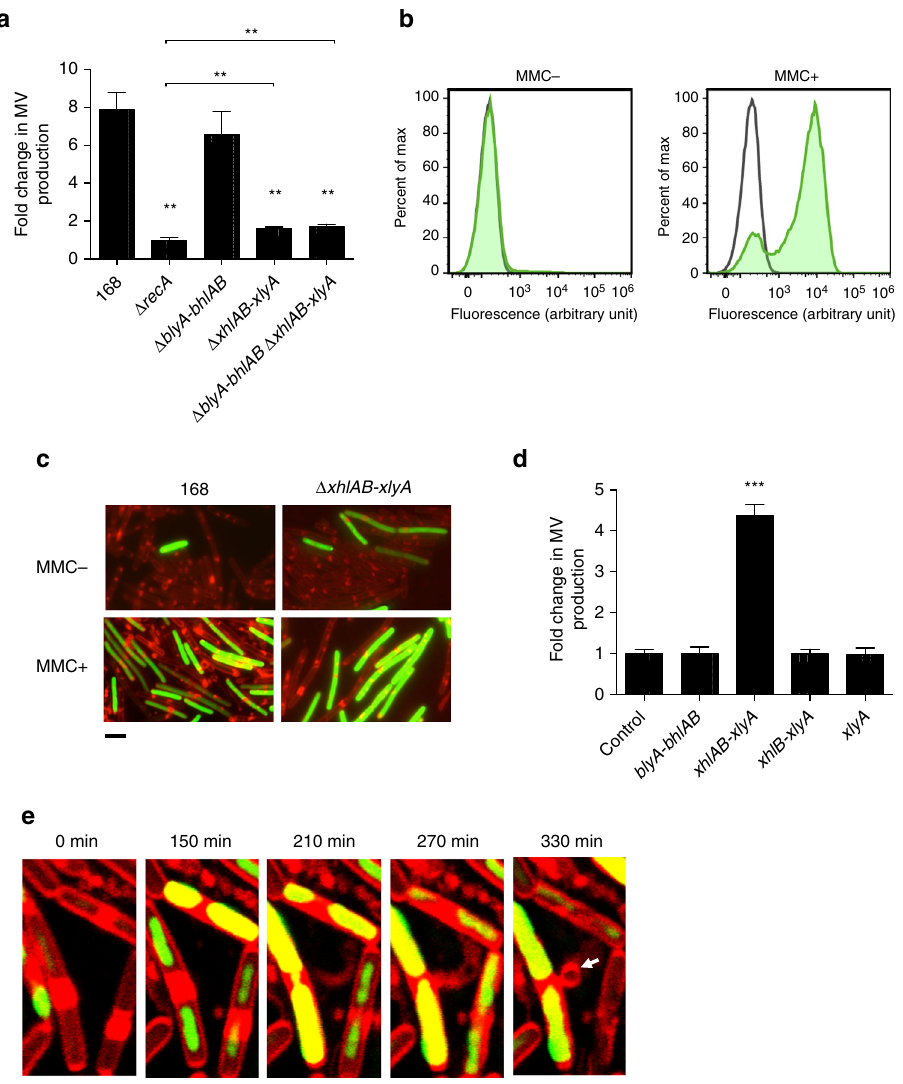
Fig. 2 Genotoxic stress induces MV formation through activation of the holin – endolysin system. a Fold-change of MV production of MMC-treated cells relative to non-treated cells. n = 3; mean ± s.d. ** P < 0.01 (unpaired t -test with Welch ’ s correction). b Expression of the PBSX holin – endolysin gene cluster is induced by MMC. A transcriptional fusion of the P L promoter, which drives transcription of the PBSX late operon (including the holin – endolysin genes), to zsGreen was quanti fi ed by fl ow cytometry. Green curve shows activity of the P L promoter; black curve shows activity of the vector control. c Promoter (P L ) activities of the PBSX holin – endolysin gene cluster under MMC non-inducing and inducing conditions. The image shows FM4-64 ( red ) merged with ZsGreen ( green ). Scale bar , 5 μ m. Phase contrast images along with the images of control experiments are shown in Supplementary Fig. 2a. d Fold-change of MV production by the expression of holin – endolysin genes relative to the control strain 168 (P xylA ). *** P < 0.001 (unpaired t -test with Welch ’ s correction). e Live cell imaging of MV formation in B. subtilis 168 (P xylA -xhlAB-xlyA ) cells. Arrows indicate MVs. Cells were incubated on LB agarose pads containing 0.1% xylose, FM4-64 ( red ) and SYTOX green ( green ). Scale bar , 5 μ large amounts of MVs. Those cells were stained by the membrane impermeable DNA dye SYTOX green, indicating that the cells ’ membranes were damaged and that DNA and cytoplasmic